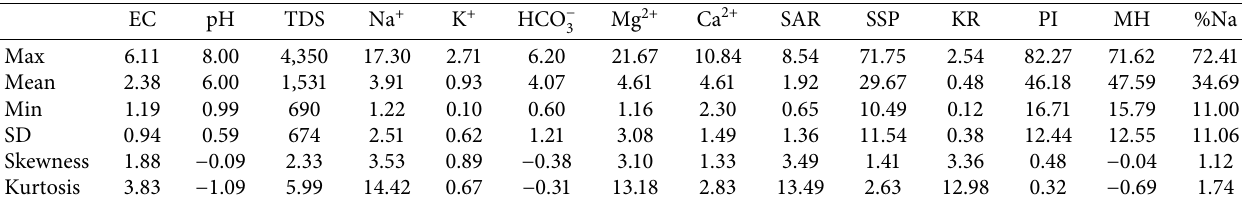
Table 1: The descriptive statistics for irrigation water quality and input